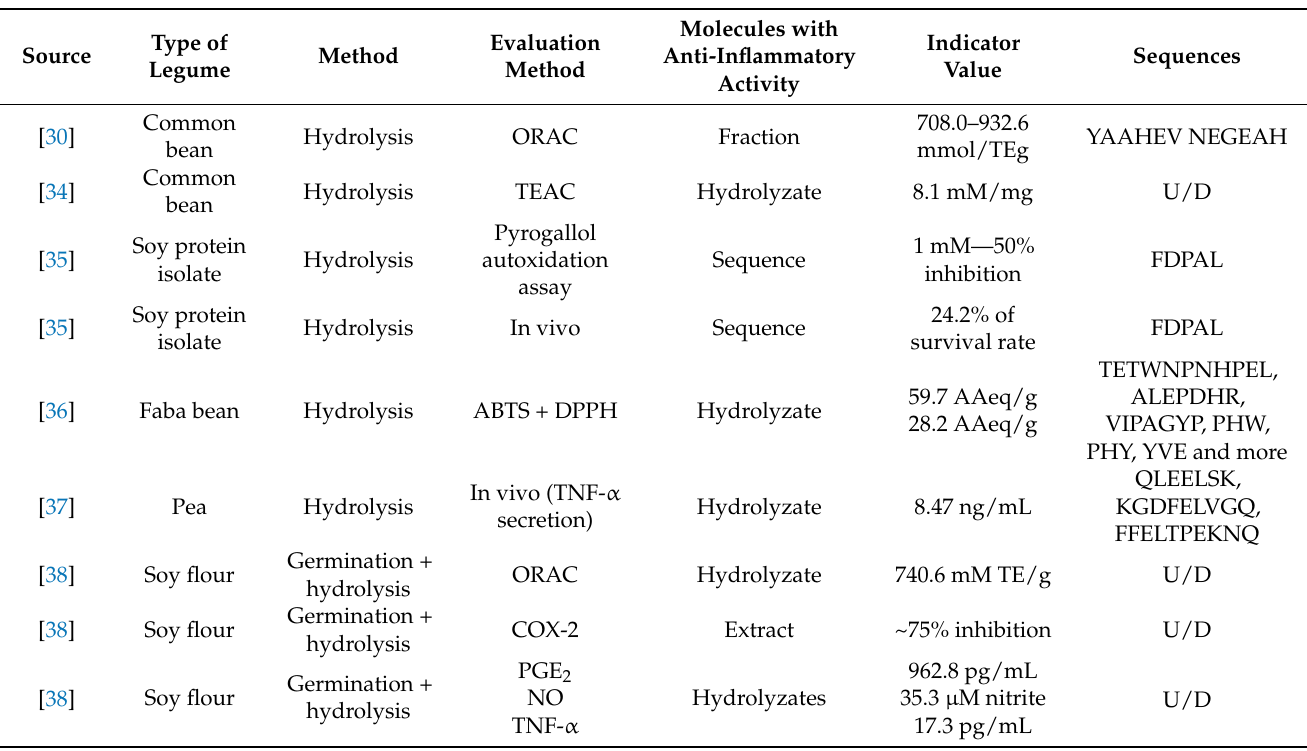
Table 3. Various indicator values and bioactive peptide sequences of investigated legumes with anti-inflammatory